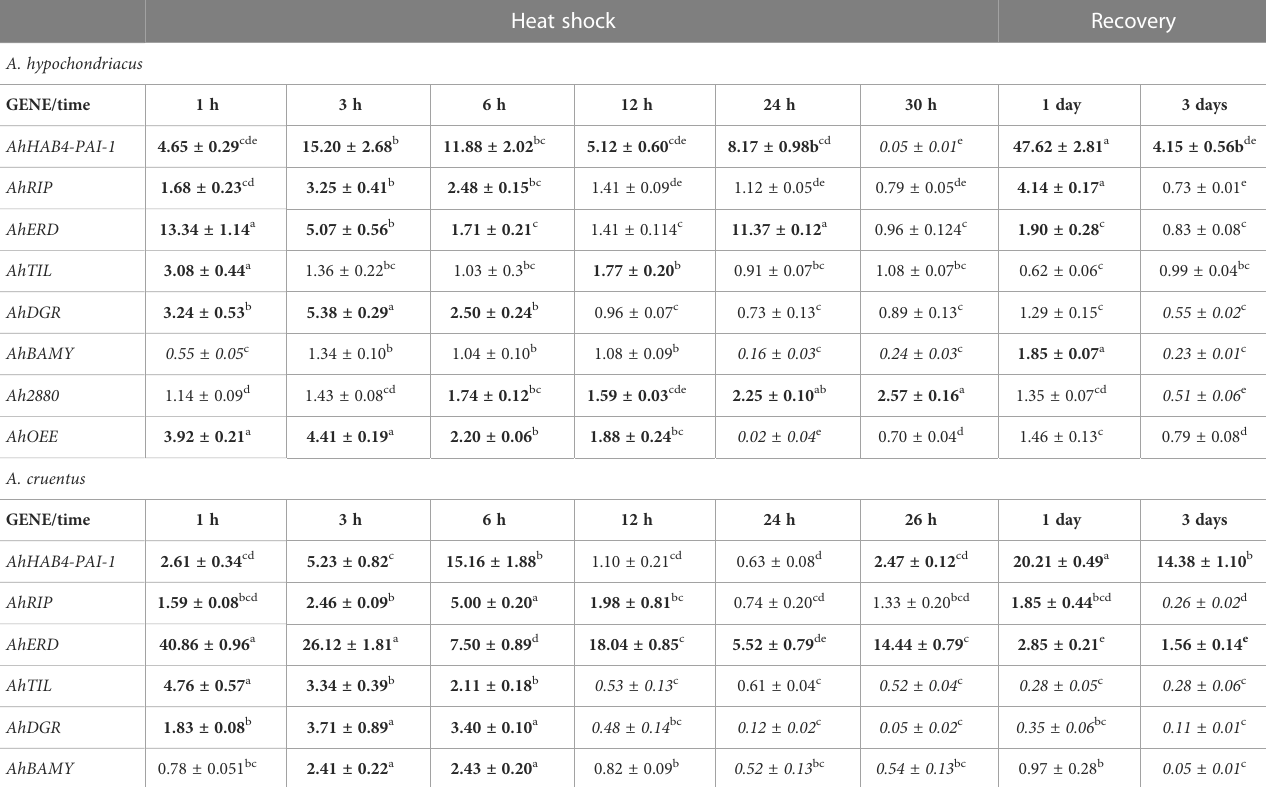
TABLE 1 Effect of heat shock and subsequent recovery on the expression of grain amaranth unknown function genes.